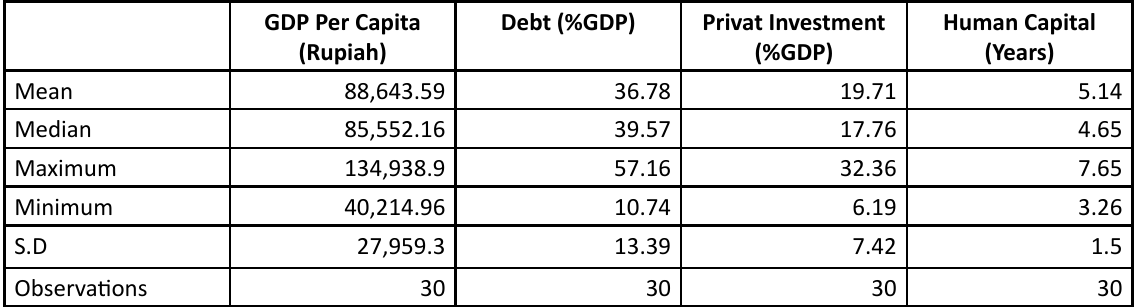
Table 4B: Descriptive Statistics - Growth Model Variables -